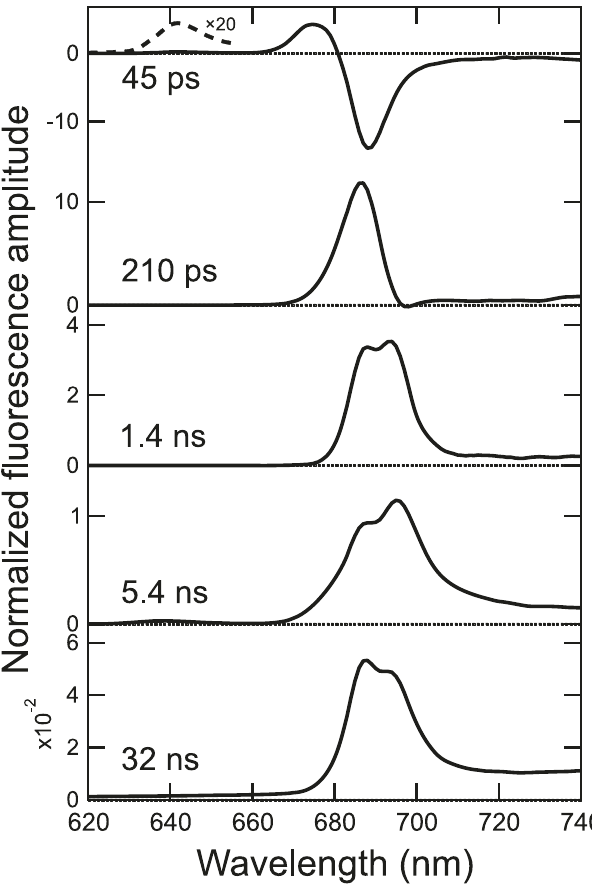
Fig. 5 Fluorescence decay-associated spectra of the PSII-FCPII supercomplex at 77 K. The spectra were normalized by the total fl uorescence intensity. Dashed spectrum was obtained by multiplication of a factor of 20, in order to visualize the 642nm decay